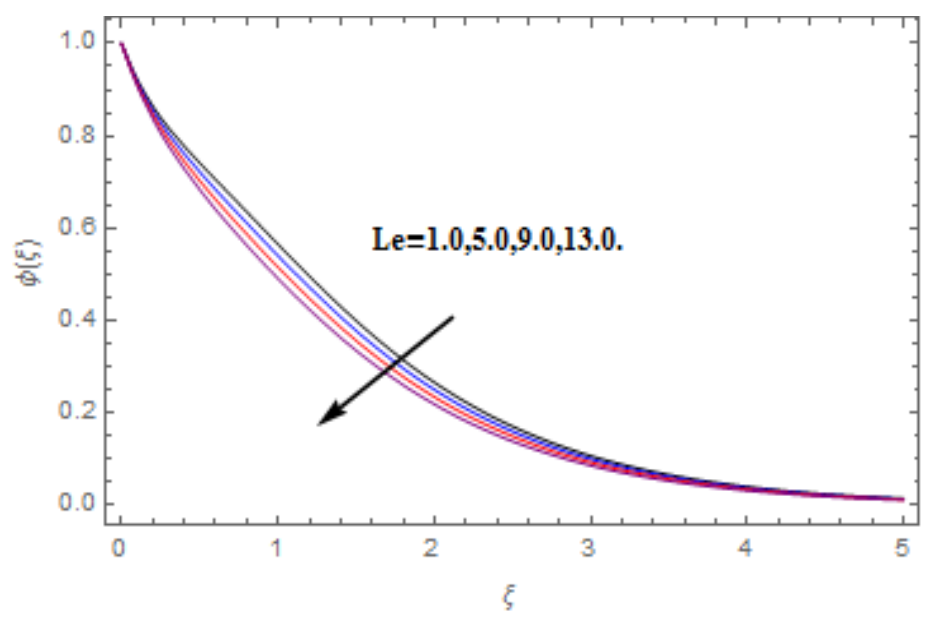
Figure 18. Varation in φ ( ξ ) against Le , when M = ψ = 0.2, Nt = Nb = 0.5, Ec = 1.0, Pr = 1.2, γ = 0.1, κ =